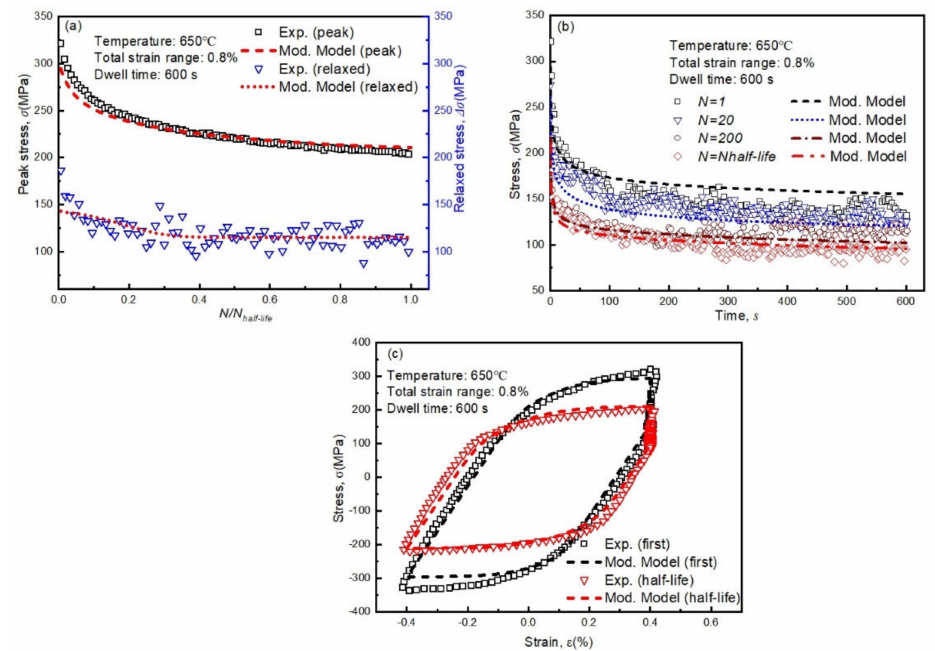
Figure 14. Comparison of simulated data and experimental results at 0.8% total strain range with 600 s peak tensile strain under 650 ◦ C: ( a ) evolution of peak stress and relaxed stress, ( b ) stress relaxation during dwell time, ( c ) hysteresis loops of first and half-life